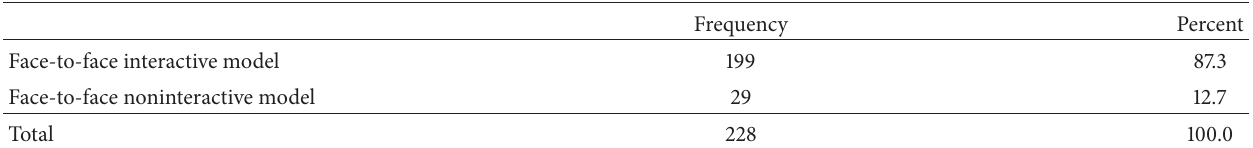
Table 3: Percentage distribution of students within dissertation supervision